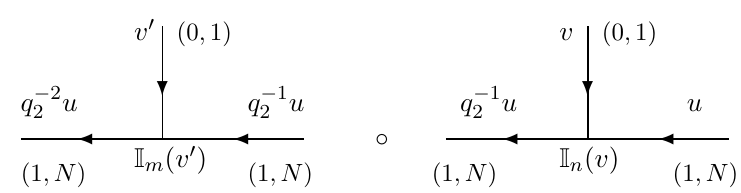
Figure 3 . Composition ◦ of the vector intertwiner and the vector intertwiner. Contrary to the Fock intertwiner, the level (1 , N ) of the horizontal Fock space is kept intact and the shift of the spectral parameter u is independent of the spectral parameters v, v 0 of the vertical